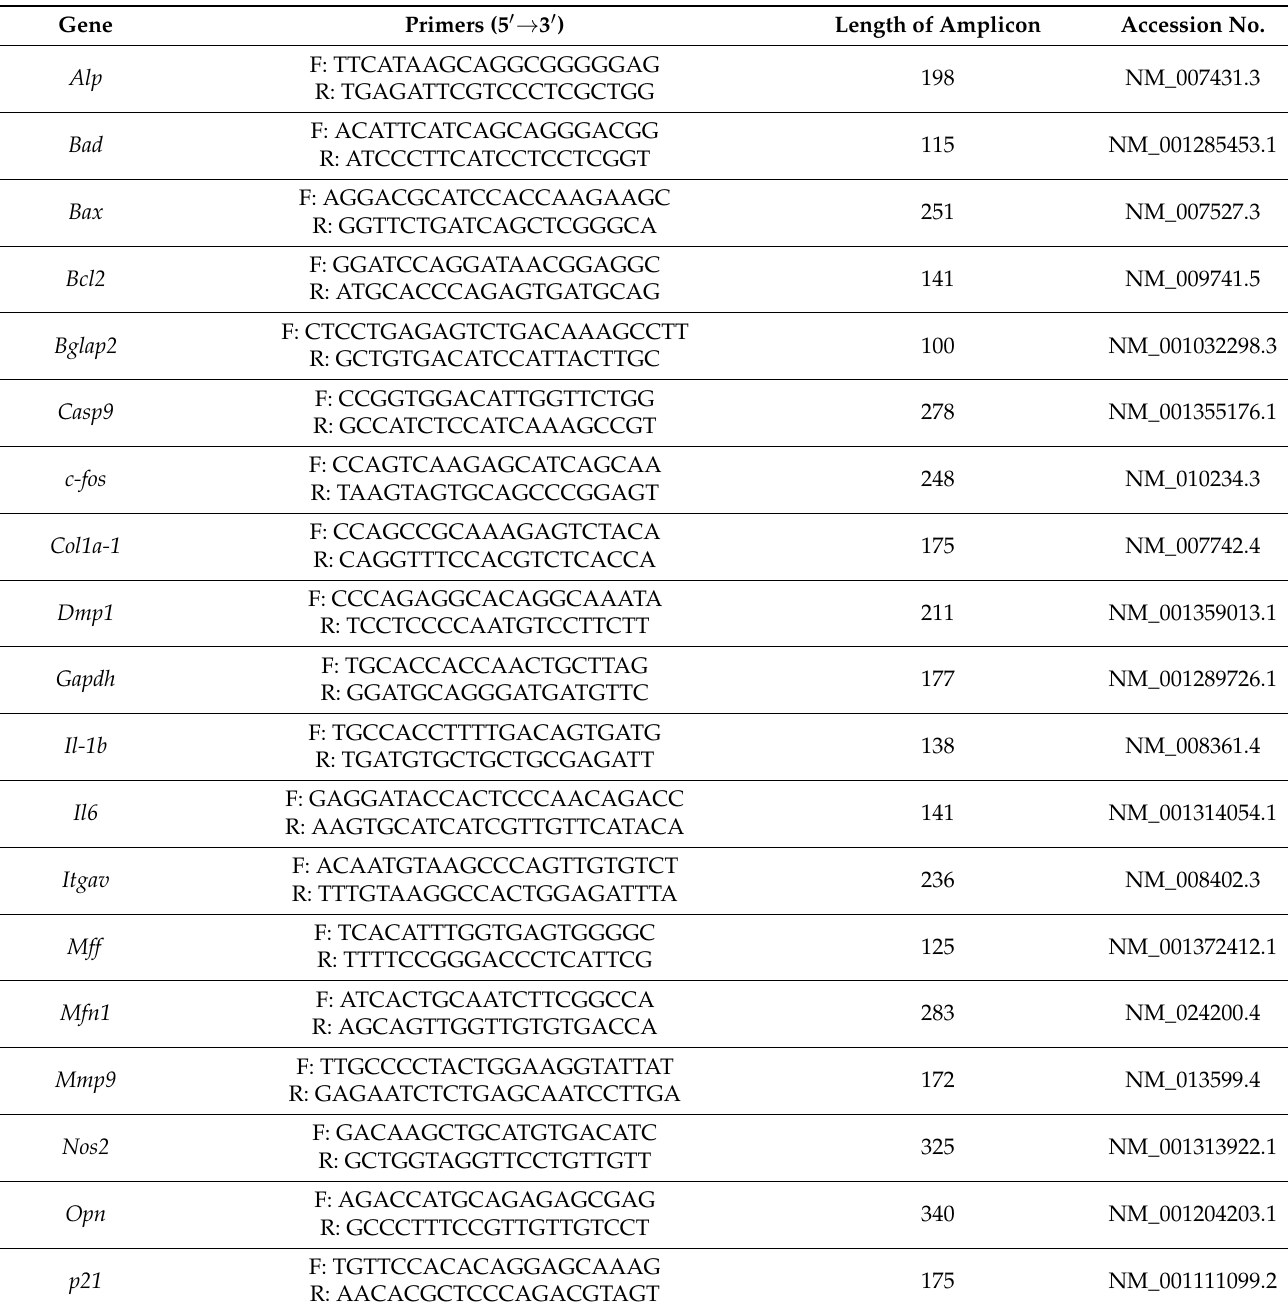
Table 2. List of primers used in RT-qPCR. Alp—alkaline phosphatase, Bad—BCL2-associated agonist of cell death, Bax—bcl-2-like protein 4, Bcl2—B-cell lymphoma 2, Bglap2—osteocalcin-2,